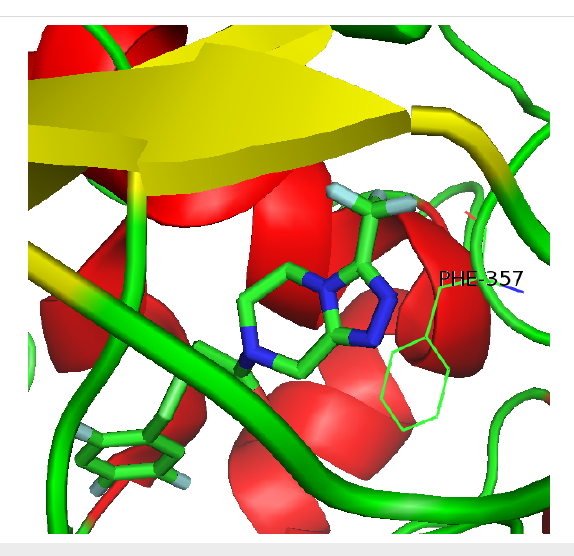
Figure 8: Binding of sitagliptin within